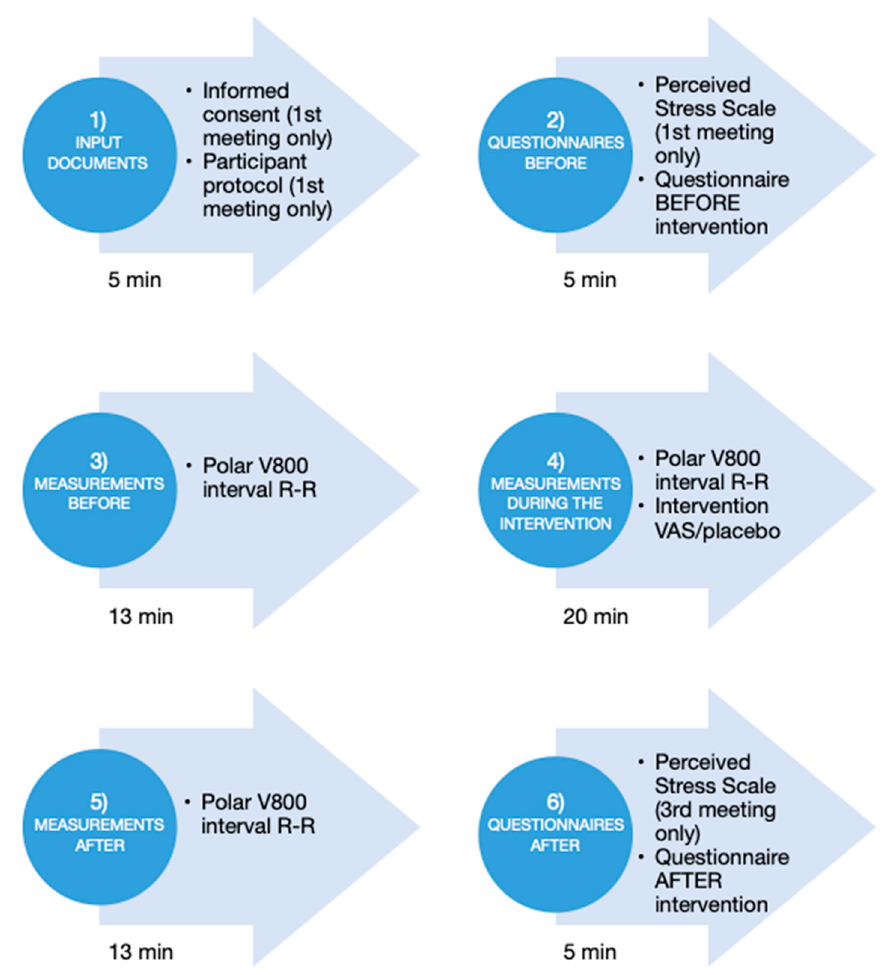
Figure 3. Procedure of the research experiment with outcome measures used (VAS-S and UWIST- MACL were included in the questionnaire before/after the intervention). Visual analogue scale (VAS) for stress [29] involves a standardized blank line, 10 cm long, anchored by the extreme values of 0 and 10. On the scale, participants recorded the degree of acute stress experienced (0 = no stress, 10 = maximum stress) before and after the